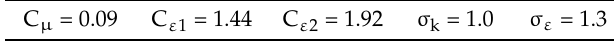
Table 1. Constants of the standard k- ε turbulence model.